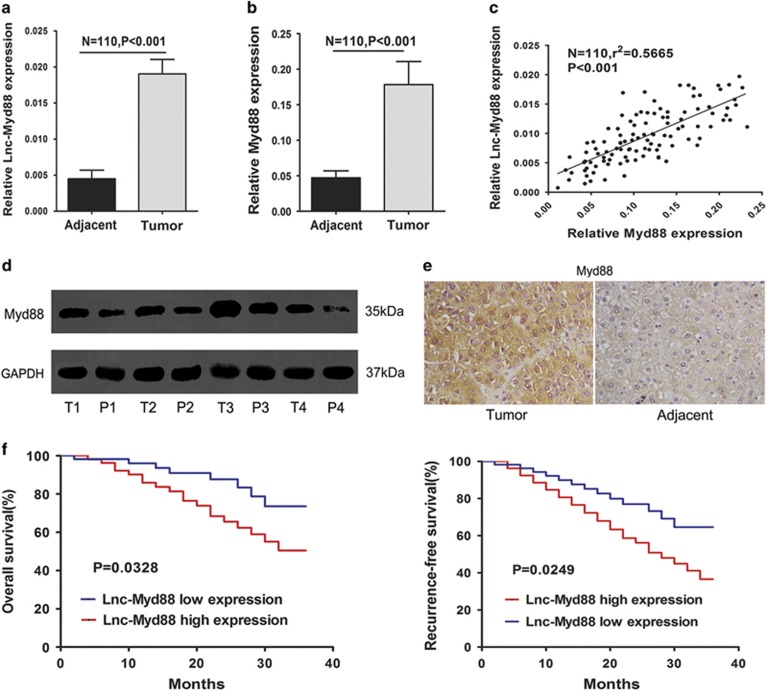
Lnc-Myd88 is upregulated with a high correlation with Myd88 in hepatocellular carcinoma tissues and correlated with poor prognosis. (a) Ectopic expression of Lnc-Myd88 in HCC tumor tissues and corresponding adjacent normal liver tissues were detected by quantitative real-time PCR normalized to GAPDH (N=110, P<0.001). (b) Enhanced expression of Myd88 in HCC tissues compared with the adjacent normal liver tissues were detected by quantitative real-time PCR normalized to GAPDH (N=110, P<0.001). (c) A positive correlation between expression levels of Myd88 and Lnc-Myd88 determined by Pearson analysis (N=110, r2=0.5665,  P<0.001). (d and e) Relative expression level of Myd88 protein in HCC tissues and adjacent tissues were tested by western blotting and immunohistochemical assays (original magnification × 200). (f) According to the median value, patients were divided into two groups according to Lnc-Myd88 expression in HCC tissues. The log-rank test was used to calculated the overall survival and recurrence-free survival of patients